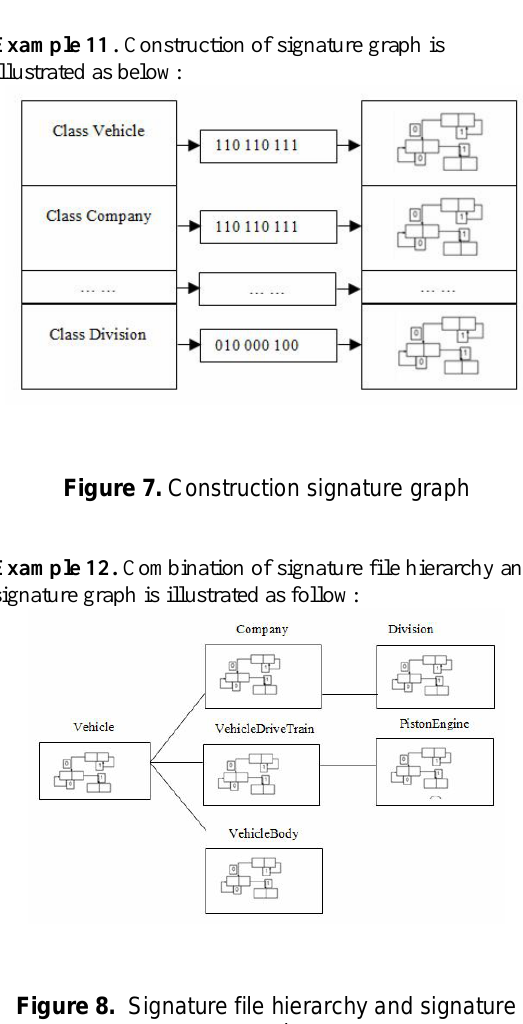
Figure 8. Signature file hierarchy and signature